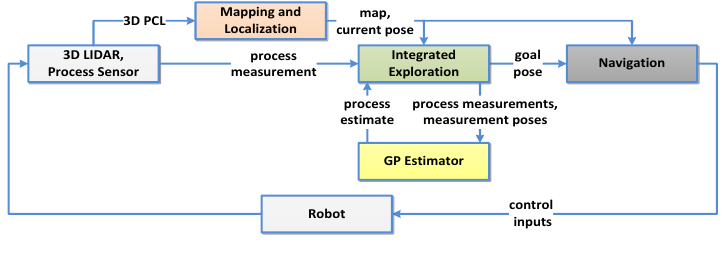
Figure 1. System overview.